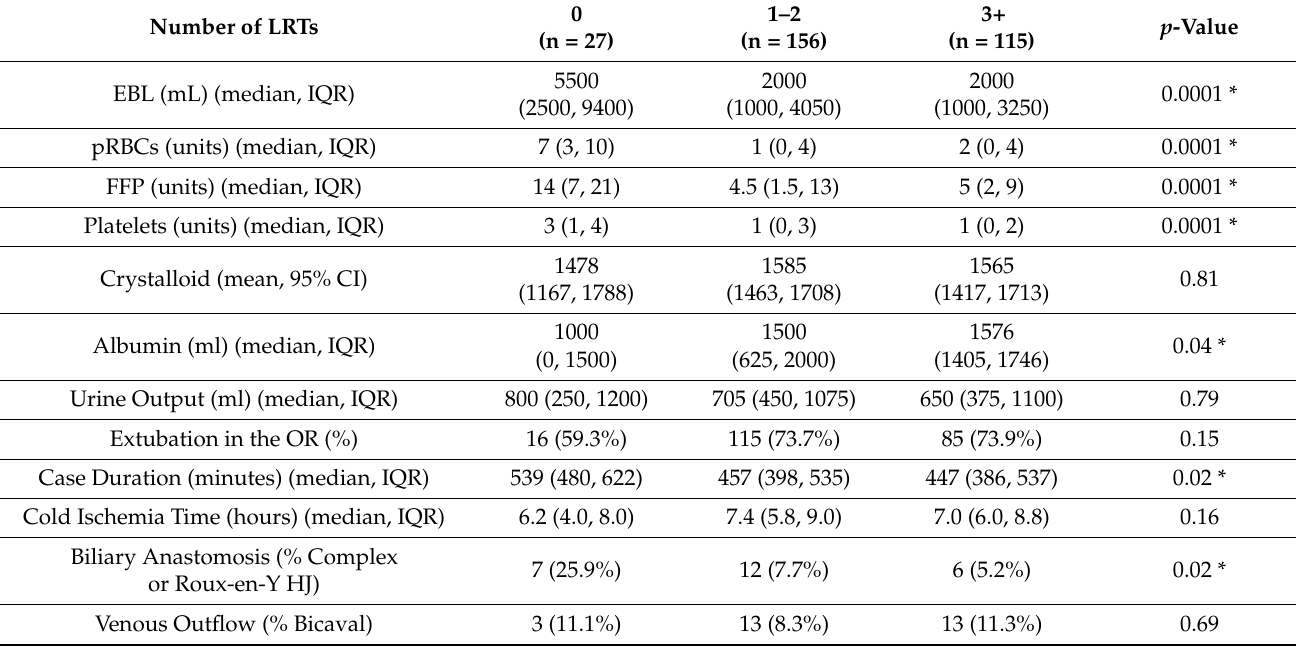
Table 2. Peri-operative Measures Stratified by Total Number of